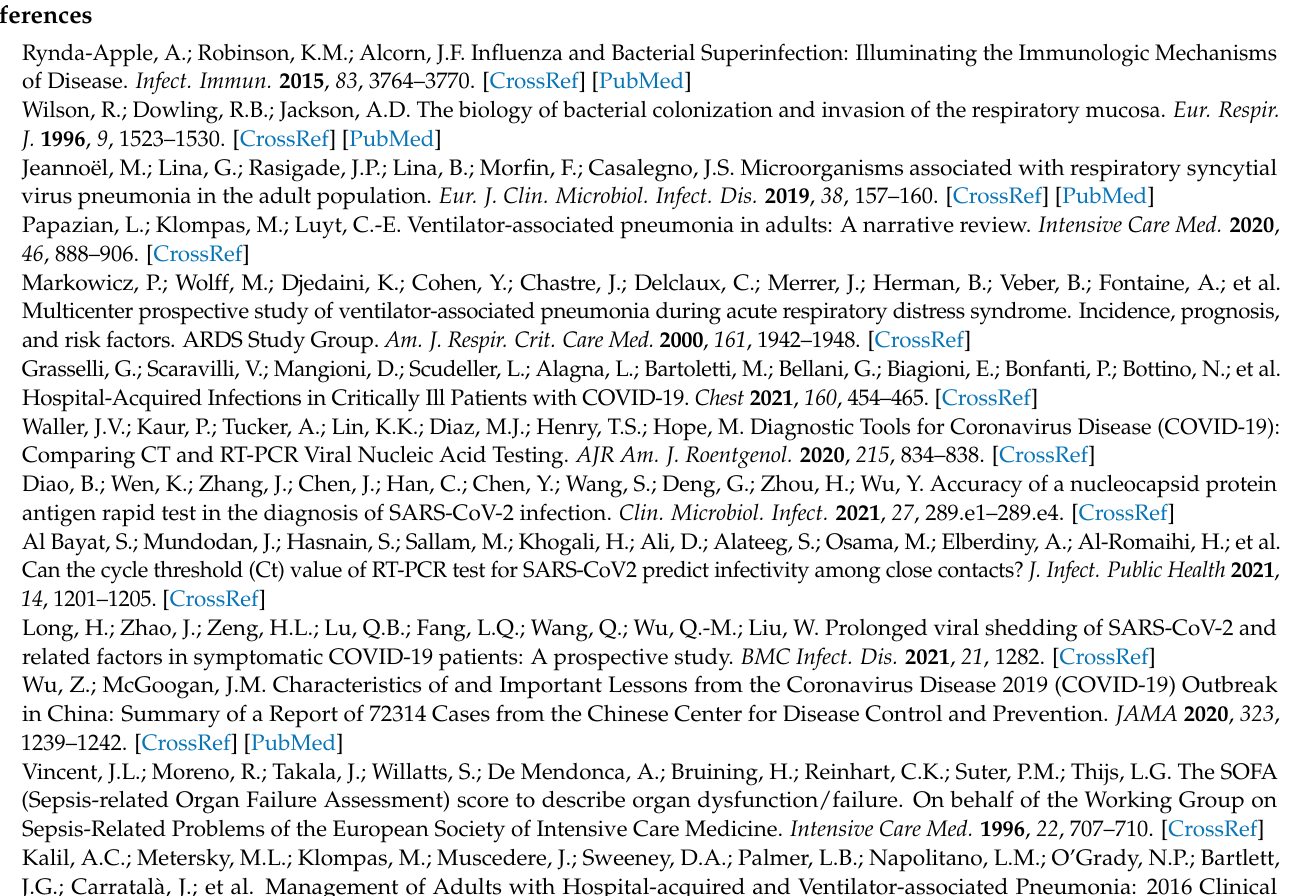
Figure A2. Analysis of the association between viral shedding and different pathogens. SM: Steno-